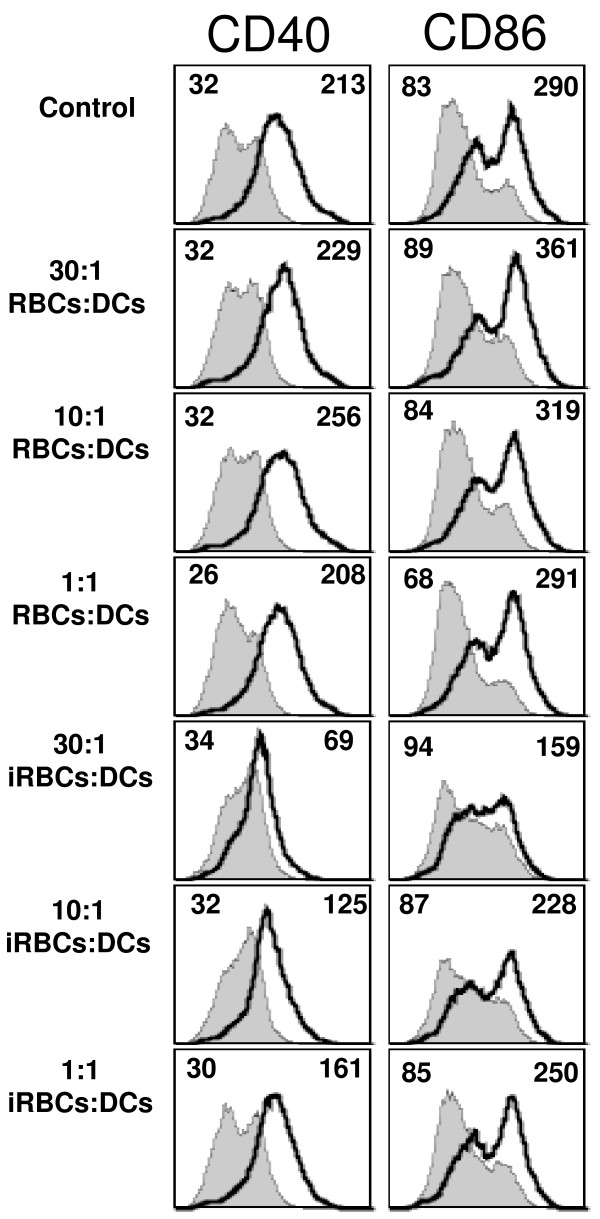
P. yoelii in vitro inhibition of DC maturation is dose dependent. DCs were incubated alone (Control), in the presence of uninfected RBCs (RBCs) or P. yoelii-infected erythrocytes (iRBCs) at the indicated ratio to DCs for 24 h followed by an additional 24 h in the presence or absence of 100 ng/ml LPS. FACS plots show CD40 and CD86 surface expression on DCs from control cultures (gray filled histograms) or incubated with LPS (black thick line). Mean fluorescent intensity (MFI) values are indicated in each plot for control and LPS stimulated. Each FACS plot is representative of one of at least 2 independent experiments.